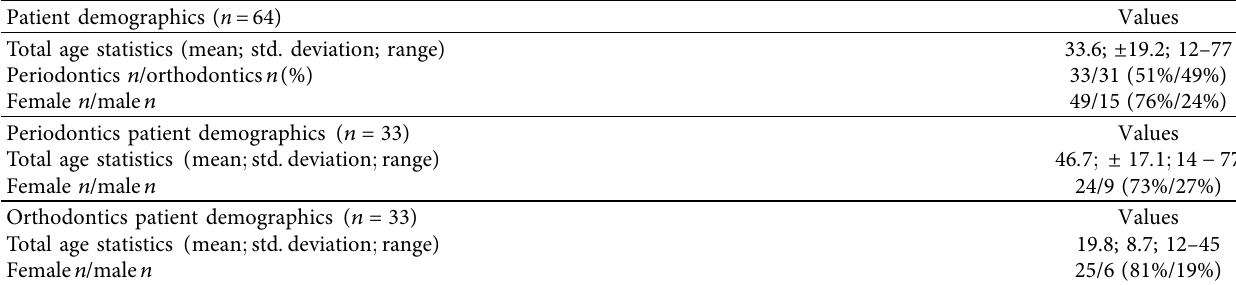
Table 1: Patient demographics.